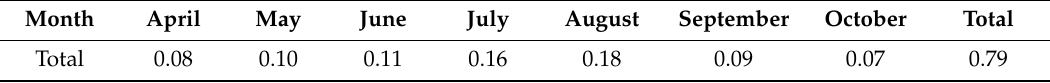
Table 6. River ecological water demand of the study area from April to October (10 8 m 3